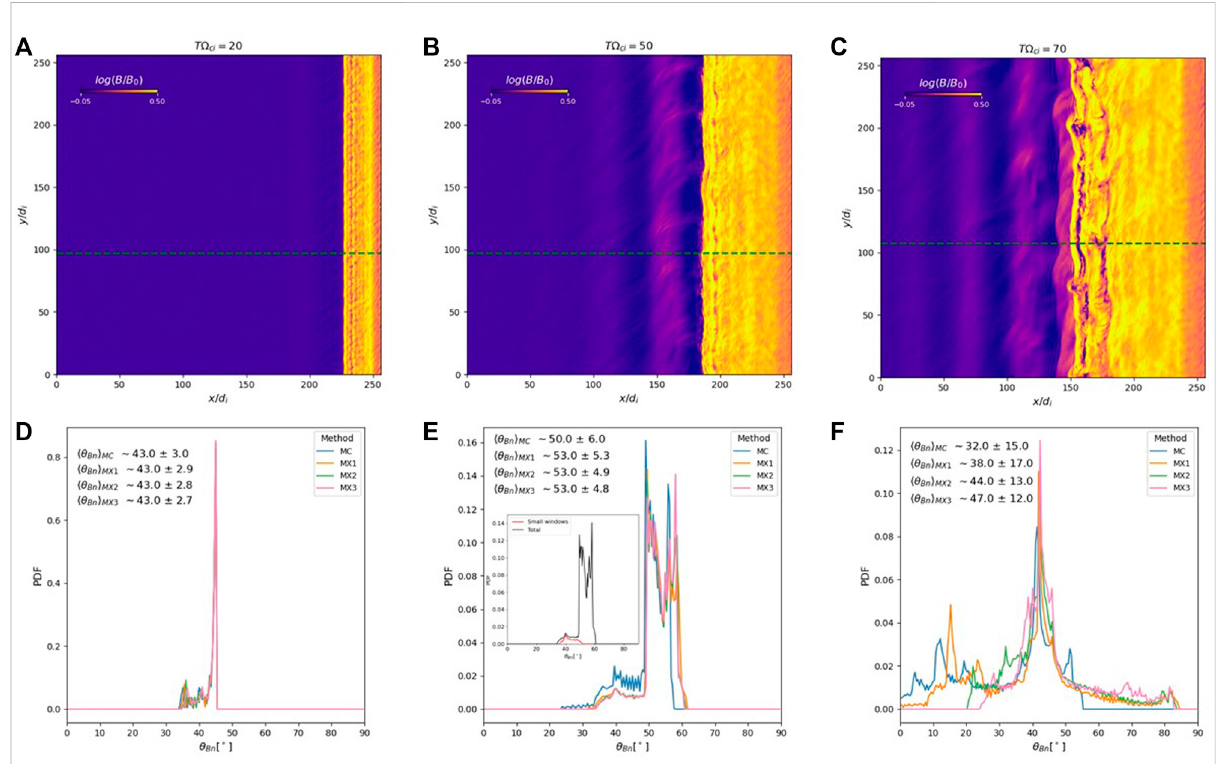
Magnetic fi eld magnitude at different stages of shock evolution (A – C) and PDF distributions of θ Bn values (D – F) evaluated on virtual spacecraft signals (with trajectories along green dashed lines) using systematic averaging window variations. The inset in panel (E) shows the full distribution of θ Bn values (black) together with the distribution of θ Bn obtained with small windows (max 2 d i )